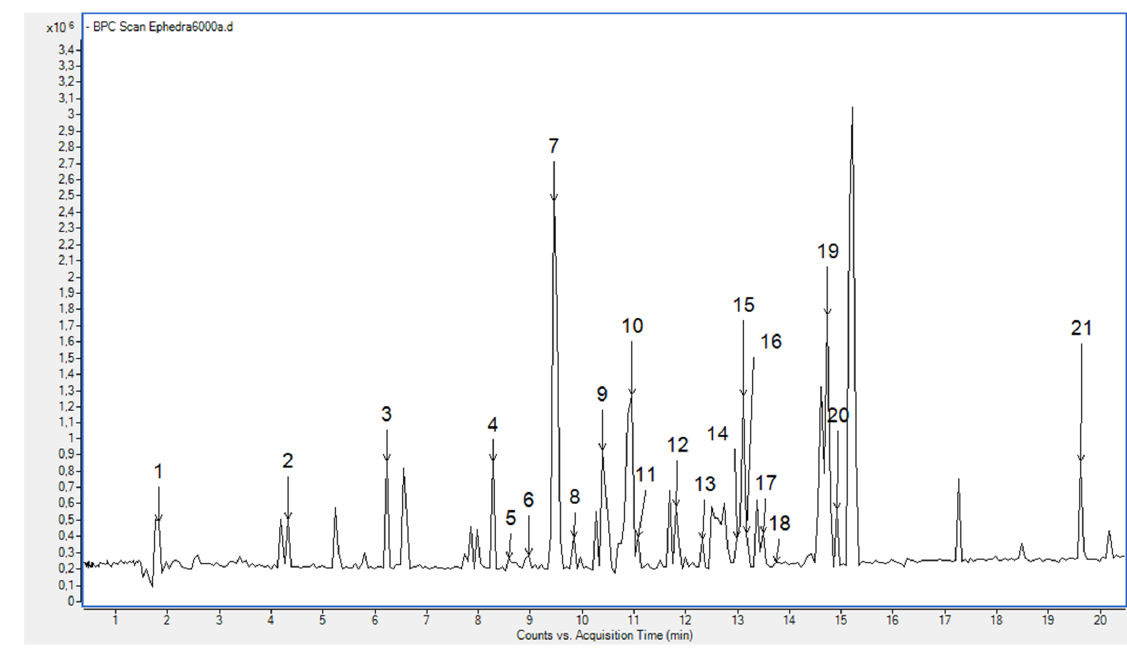
Figure 1. BPC of the EamCE. Table 2. RP–UHPLC–ESI–QTOF–MSn data of flavonoids and phenolic acids identified in the aerial parts of E. alata monjauzeana.